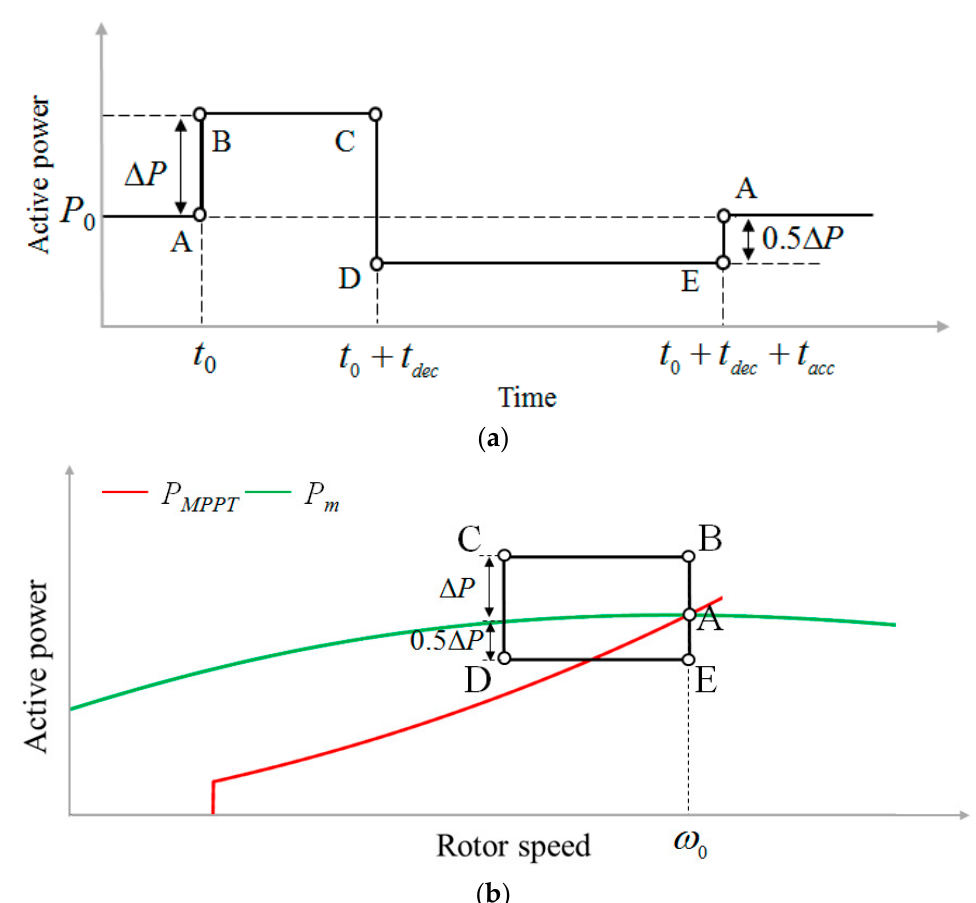
Figure 3. Power reference of SIC #1. ( a ) Power reference in the time domain; ( b ) Power reference in the rotor speed domain.